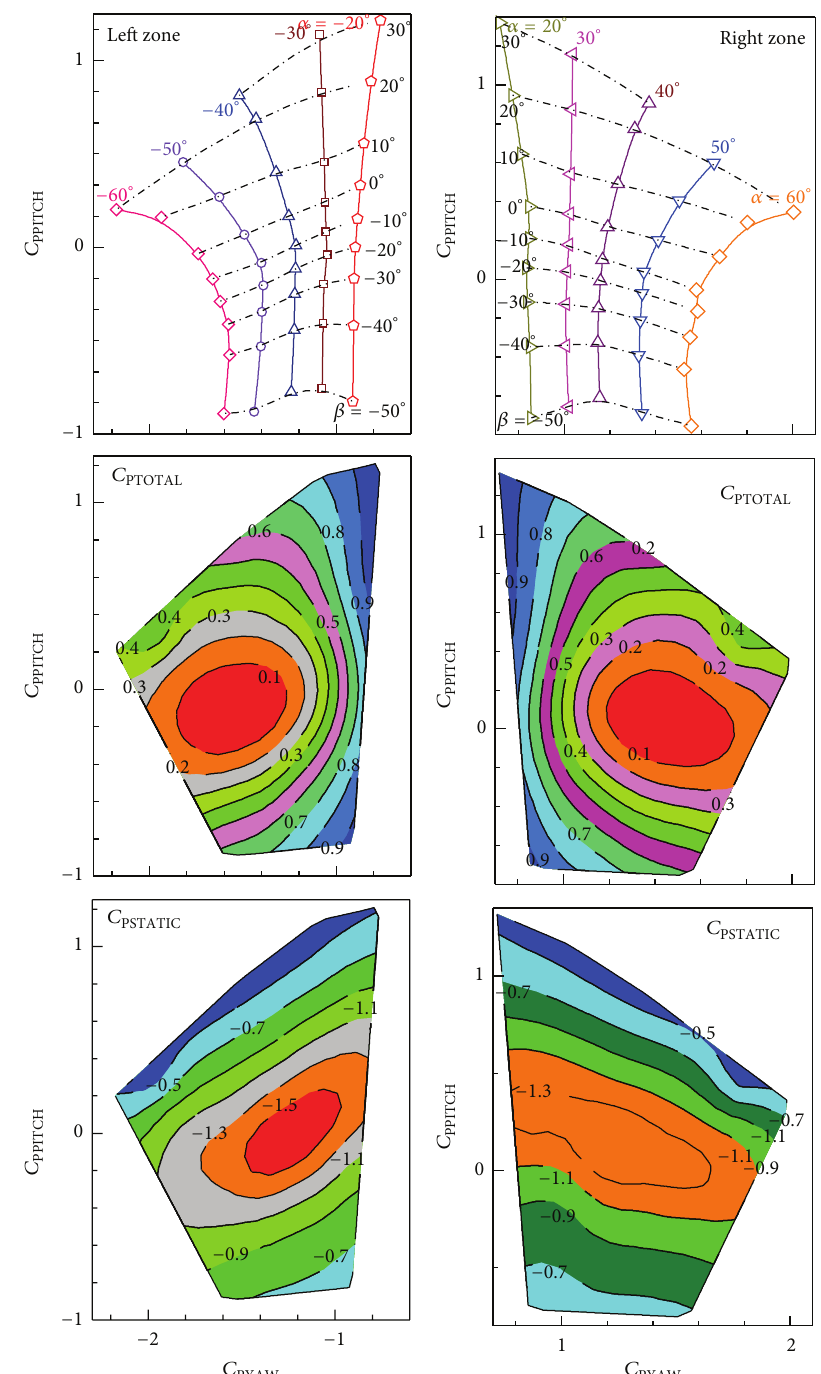
Figure 7: Calibration curves of the four-hole probe for the left and right